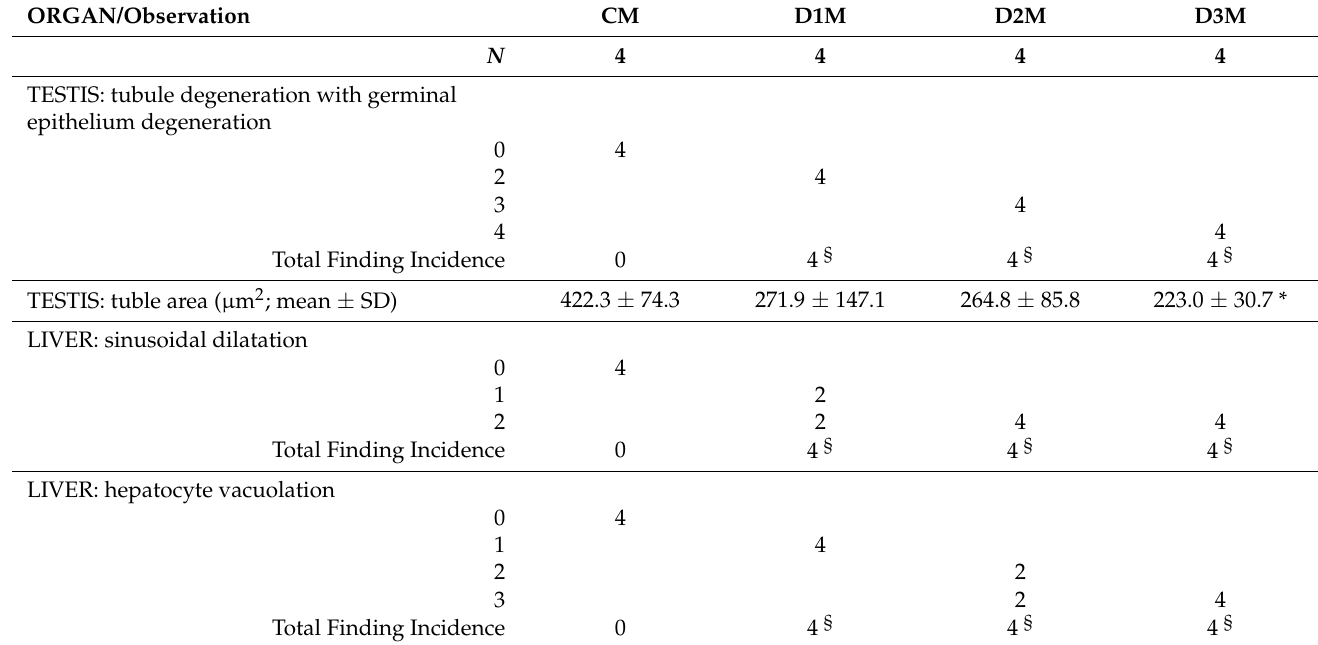
Table 3. Histopathological endpoints in target organs of male rats subcutaneously treated with different doses of estradiol valerate plus cyproterone acetate, five times a week, for 2 weeks: